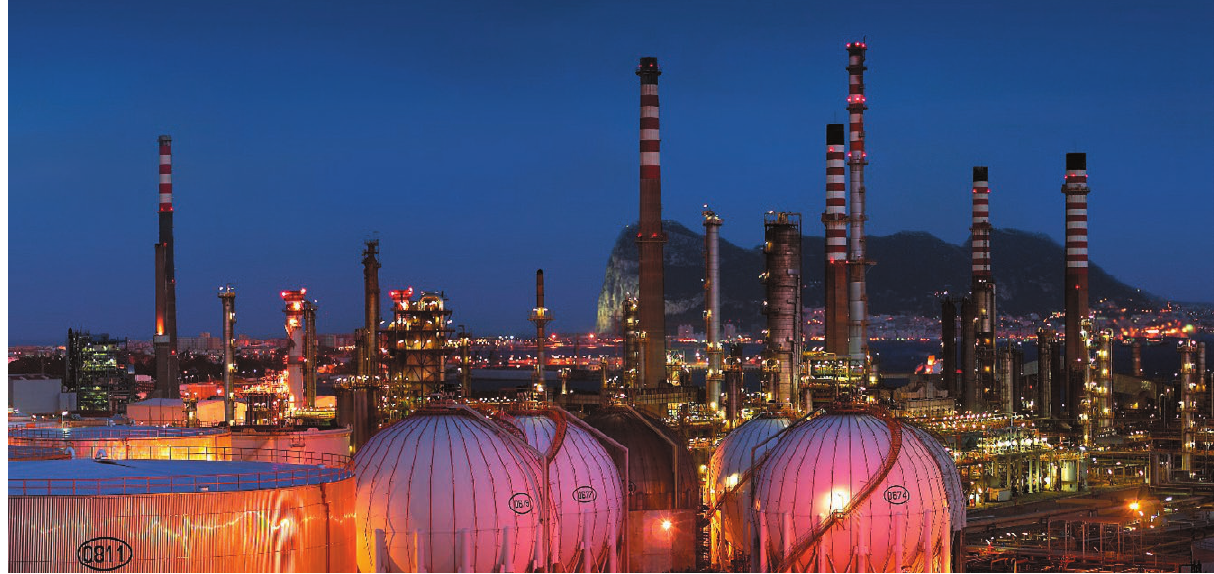
Figure 10. Complex Refinery (CEPSA Gibraltar San Roque) in 2021. Reproduced with permission from